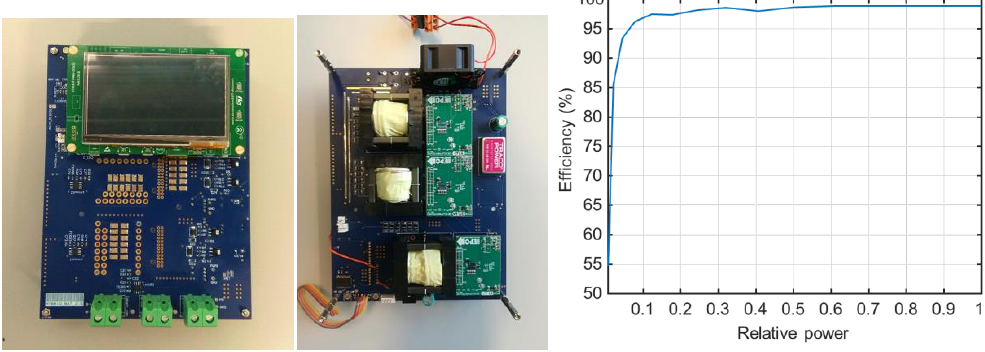
Figure 14. Buck-boost converter front ( left ), Buck-boost converter rear ( center ), measured e ffi ciency of Figure 14 . Buck-boost converter front (left), Buck-boost converter rear (center), measured efficiency the converter ( right of the converter (right)